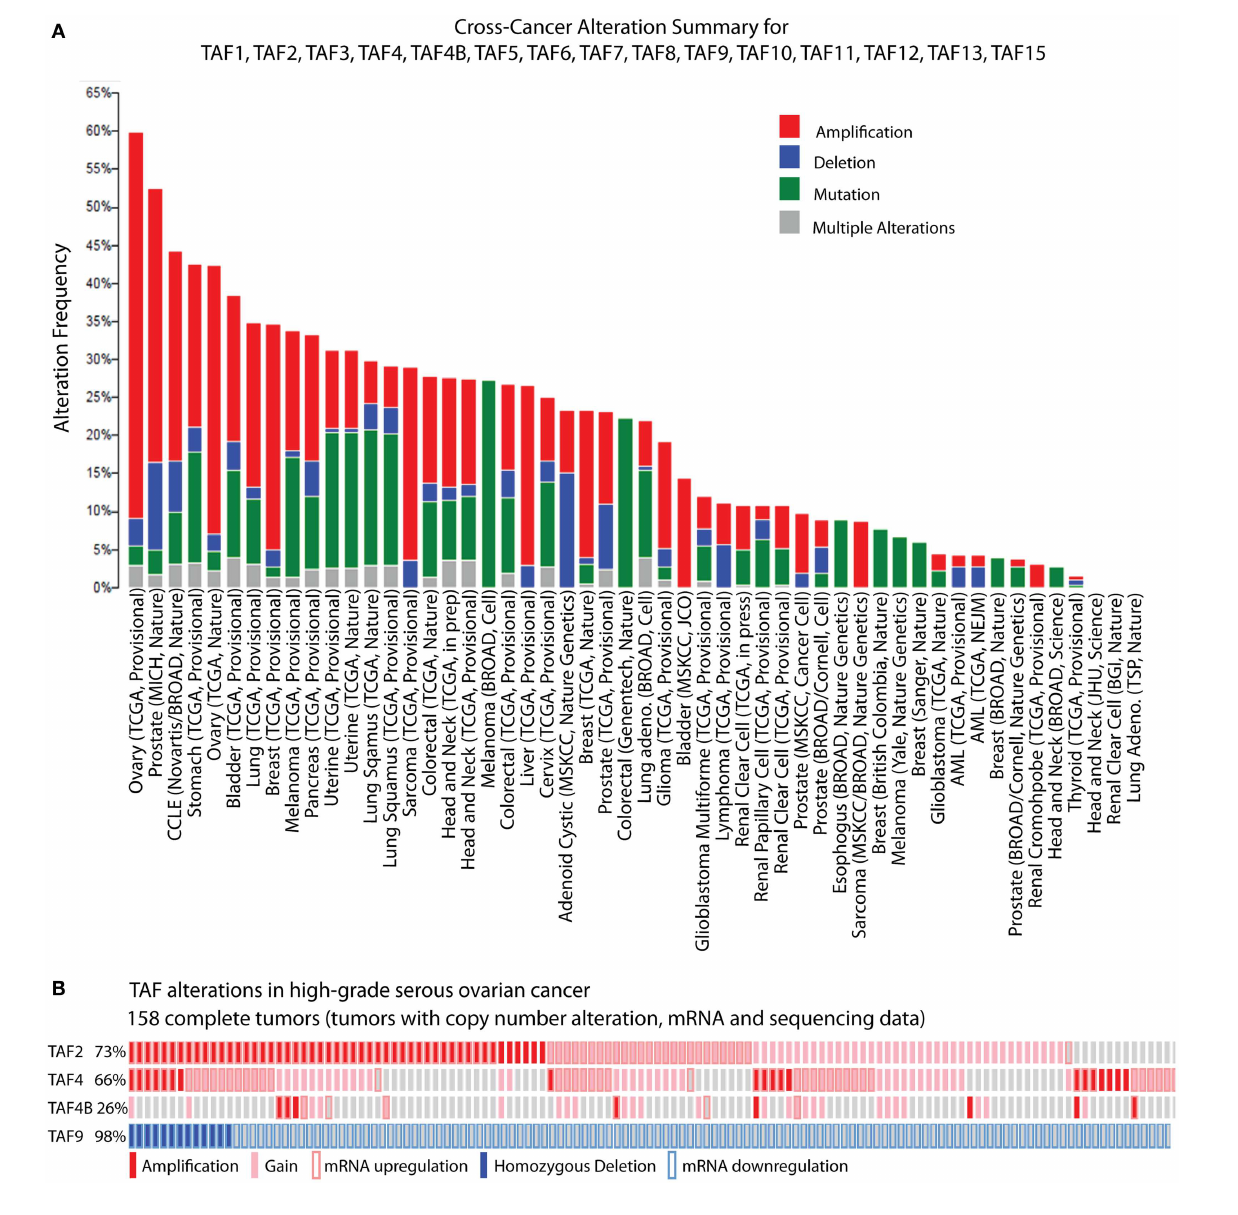
FIGURE 2 |TBP-associated factor alterations in high-grade serous ovarian cancer (HGSC) . (A) Cross-cancer summary of copy number alterations and mutations inTAFs for all cancer sets in the cBioPortal for Cancer Genomics (2, 3). (B) Amplifications, copy number gains, and mRNA upregulation ofTAF2,TAF4, andTAF4B, and deletions and mRNA downregulation ofTAF9, in the cBioPortal HGSC set (TCGA, provisional, complete tumors) (2, 3).These “oncoprints” are partial views of alterations in 158 complete tumors. Alterations are present in 158 complete tumors in the percentages noted on the left.